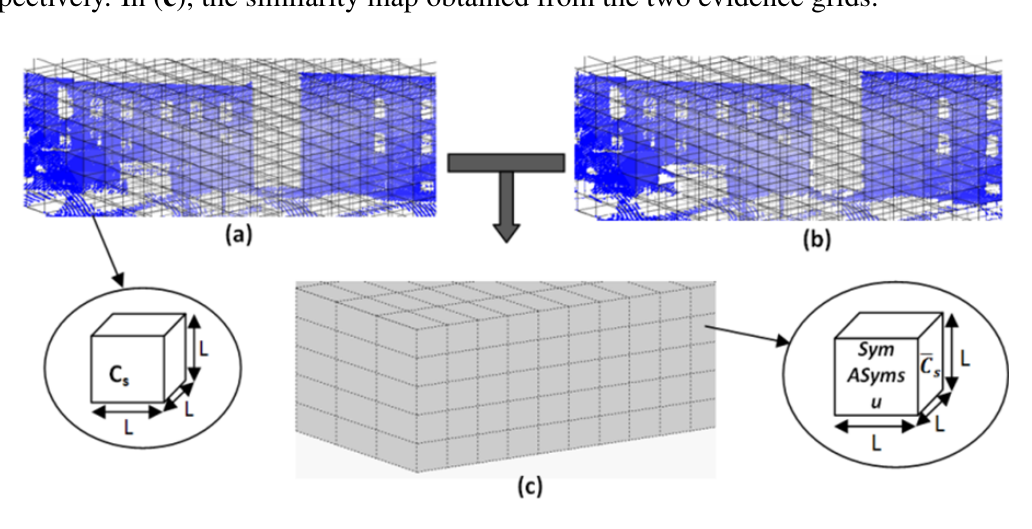
Figure 6. Formulation of 3D evidence grids and similarity map. (( a ) and ( b )) show the ) and P ( n − 1) ) mapped onto an evidence grid of cell size, L 3 , 3D point clouds ( P ( n p p respectively. In ( c ), the similarity map obtained from the two evidence